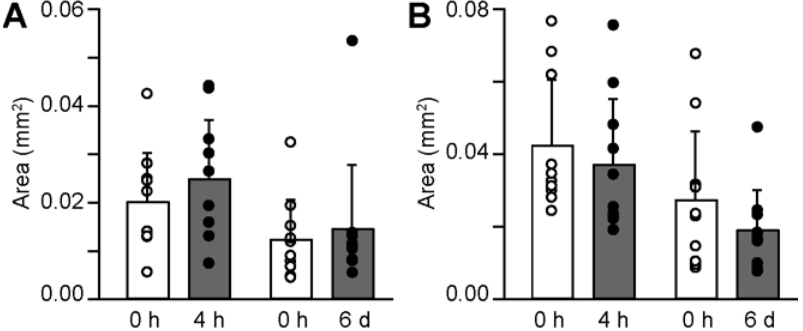
Figure 4. Sphere area. ( A ) Area of sphere clumps of MD13 cells at 6 days after treatment with 2% sevoflurane for 0 h, 4 h, or 6 d. ( B ) Area of sphere clumps of Me83 cells at 6 days after treatment with 2% sevoflurane for 0 h, 4 h, 6 d. Data are presented as mean ± SD ( n = 10). Differences between groups were evaluated using one-way analysis of variance. All p -values for 4 h or 6 d compared to 0 h were greater than 0.05.